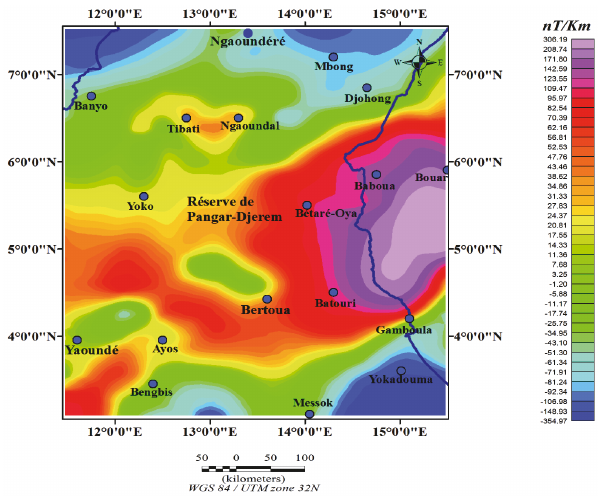
Figure 5: Residual map of TMI-RTE upward continued at